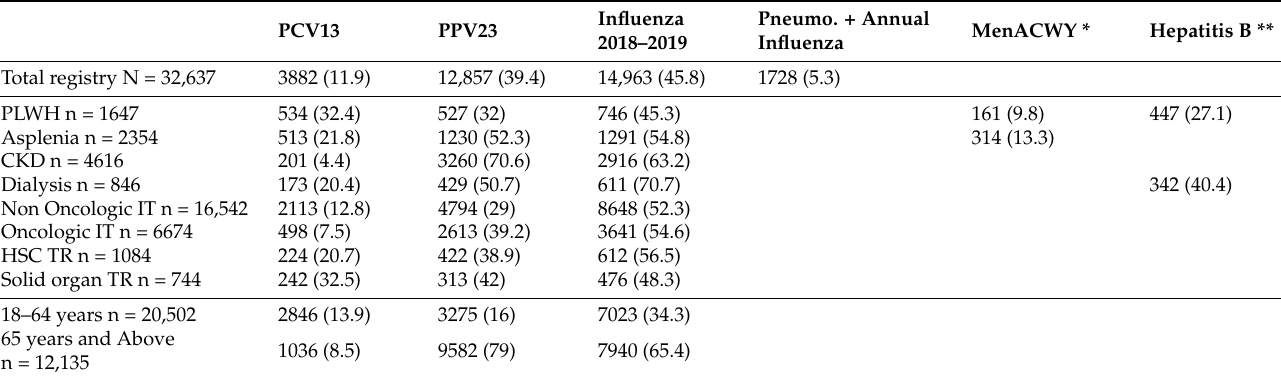
Table 2. Immunocompromised patients in registry and vaccination rate, Israel,